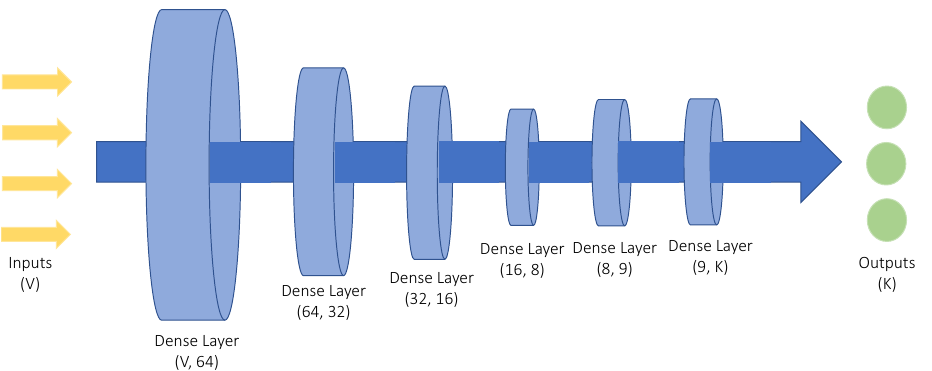
Figure 2. The proposed DNN architecture, receiving V features as an input and producing K